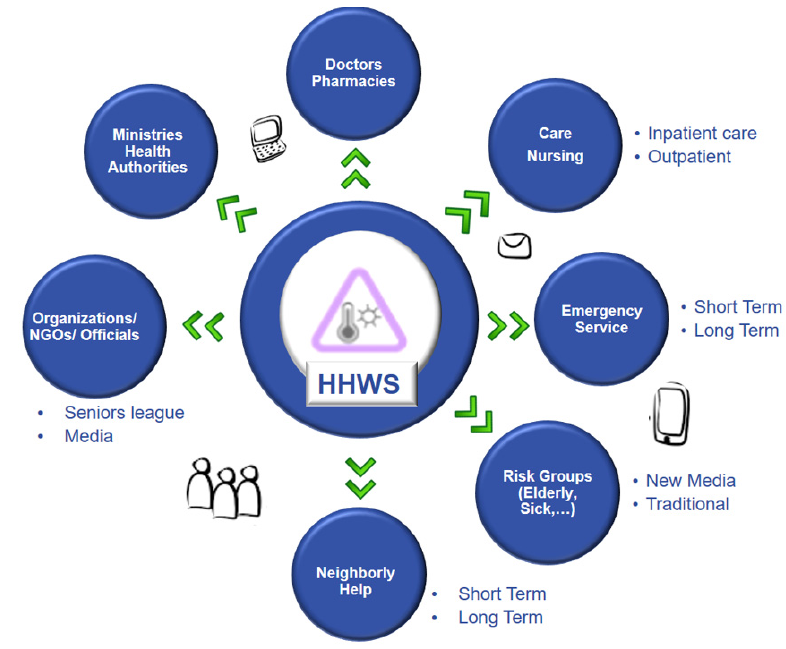
Figure 1 . Communication paths for heat health warnings. Figure 1. Communication paths for heat health